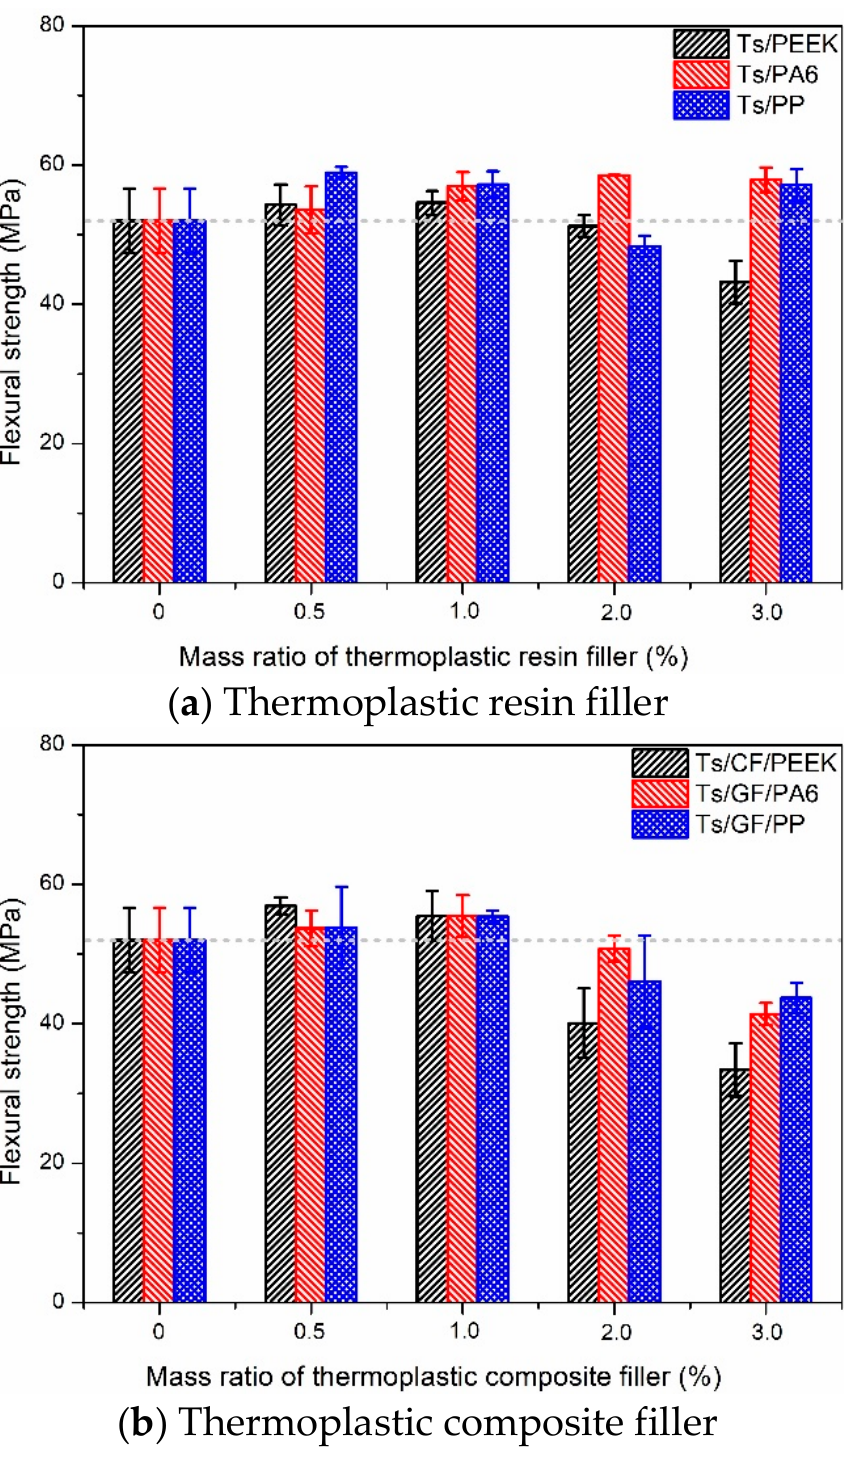
Figure 6. Effects of thermoplastic resin and composite fillers on the flexural strength of Ts resin of ( a ) thermoplastic resin filler and ( b ) thermoplastic composite filler.